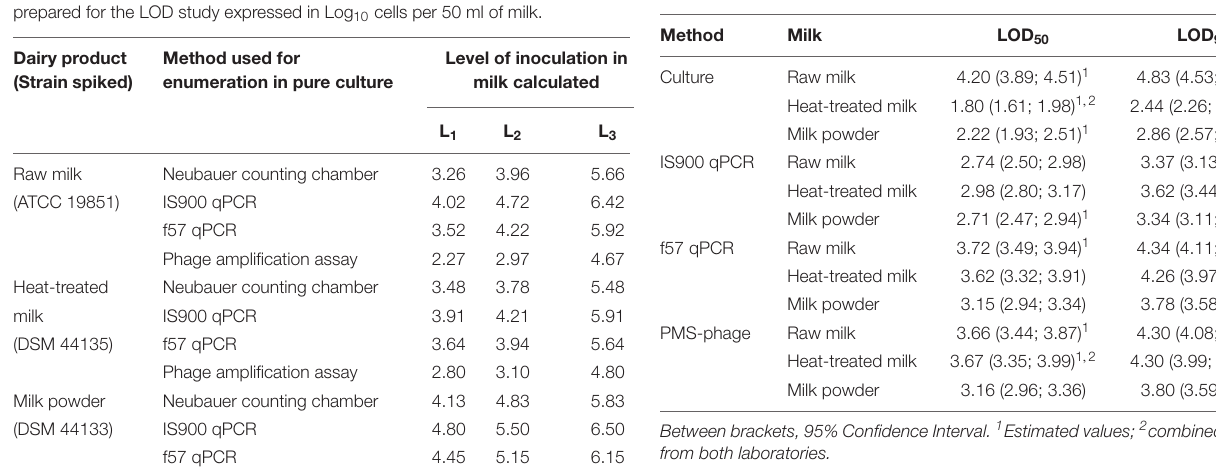
TABLE 6 | LOD 50 and LOD 95 results obtained for all methods and dairy categories tested and expressed in Log 10 CFU/50